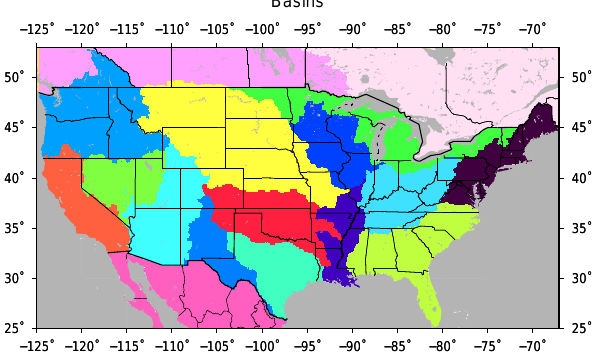
Fig. A1. River basin delineations used in archiving the forcing datasets. Regions include: 1 – Northwest and Columbia; 2 – Cal- ifornia; 3 – Great Basin; 4 – Colorado River; 5 – Rio Grande; 6 – Missouri River; 7 – Arkansas-Red; 8 – South Central (Gulf); 9 – Great Lakes Drainage; 10 – Upper Mississippi; 11 – Lower Missis- sippi; 12 – Ohio; 13 – North East; 14 – South East; 15 –